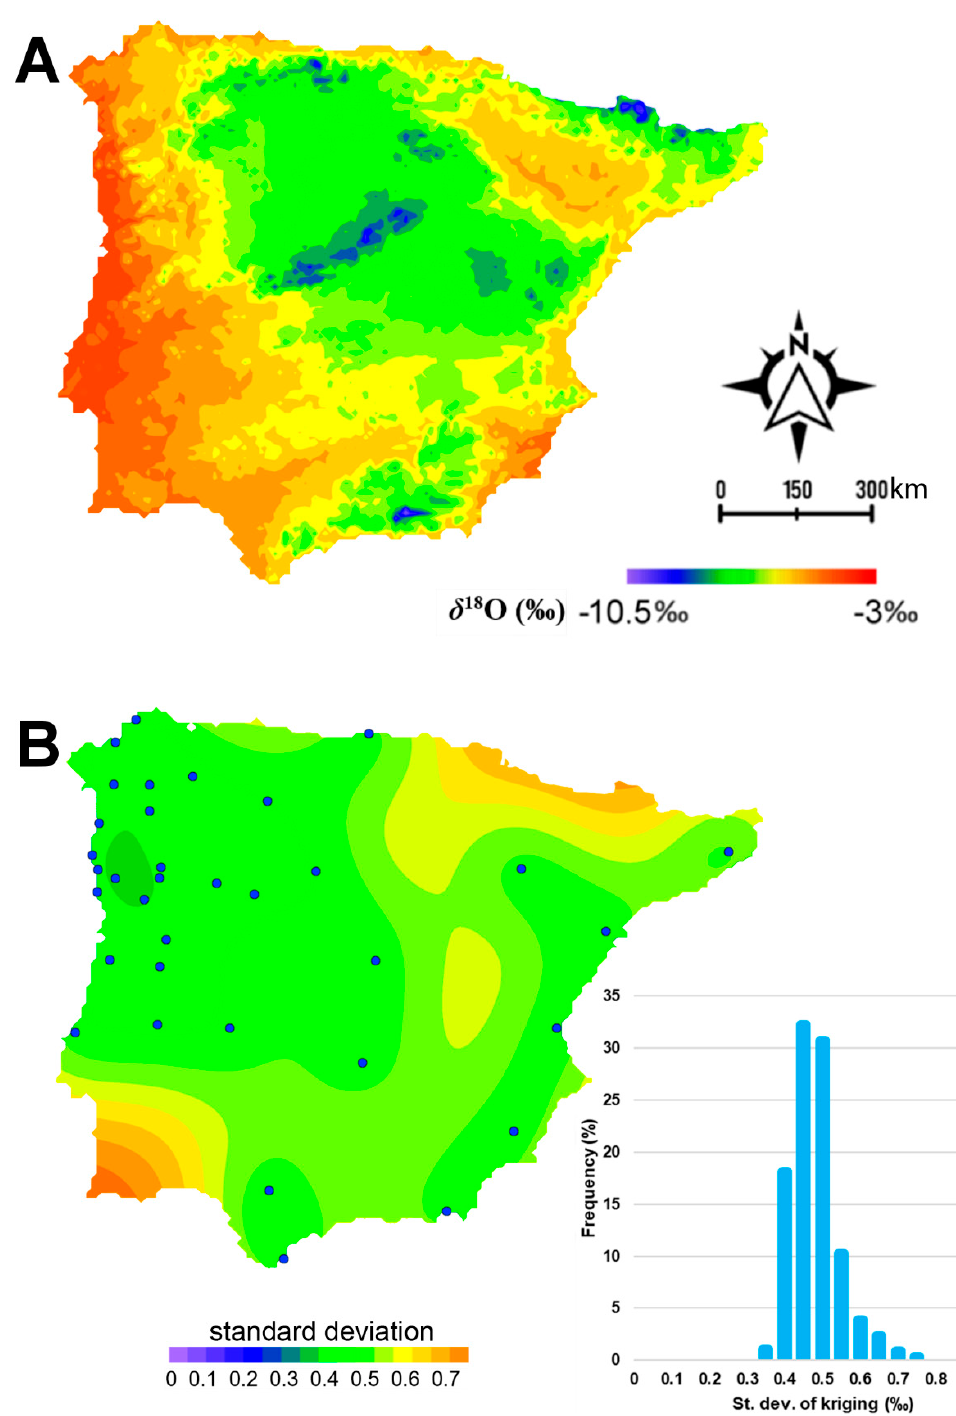
Figure 6. Predicted amount-weighted δ 18 O p isoscape for the Iberian Peninsula for October 2004–July 2006 ( A ) and the standard deviation of kriging ( B ). Grid resolution: 10 × 10 km. The histogram in panel ( B ) shows the frequency / abundance of the kriging error in 0.1 bins. The north arrow and scale in panel A is relevant for both maps and the black dots represent the precipitation sampling sites used in the geostatistical analysis representing October 2004–July 2006. The δ 18 O p values that were indicated by the obtained isoscape range between − 10.55 and − 3.97% Data products and estimated spatial errors of the global regionalized cluster-based water isotope prediction (RCWIP) model [16] are both freely available [61], so detailed numerical comparison between the Iberian subset of RCWIP model and the current regionally fitted δ p isoscapes could be calculated by subtracting the present model values from the resampled (10 × 10 km) RCWIP ones.